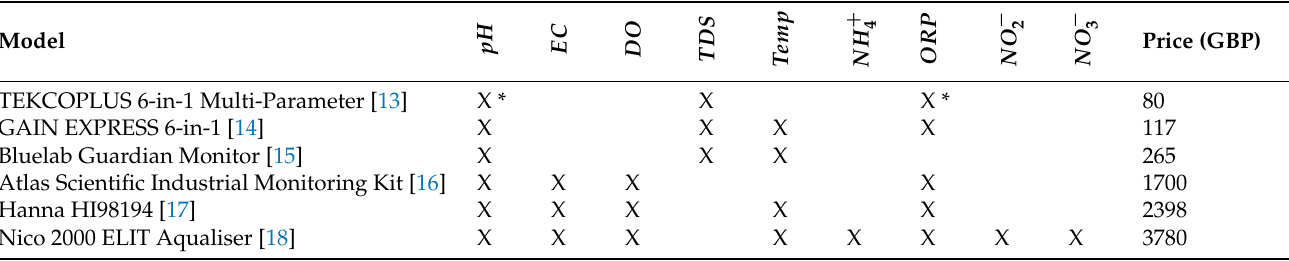
Table 1. Existing Remote IoT Sensor Models.